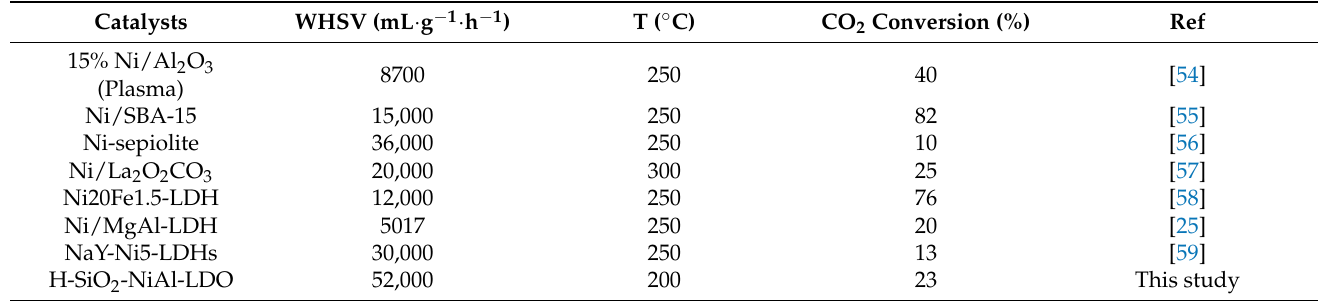
Table 4. Comparison of low temperature catalysts prepared via different